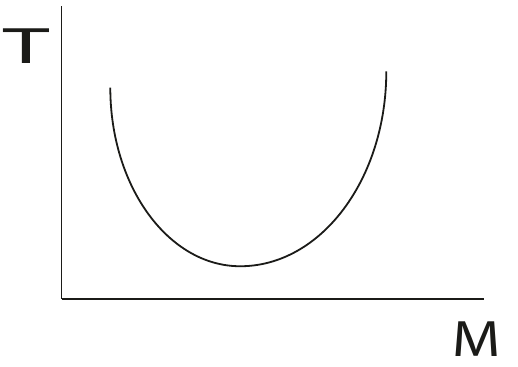
Figure 1 . Temperature as a function of mass for the AdS black hole. The region where @ M T < 0 is the small black hole